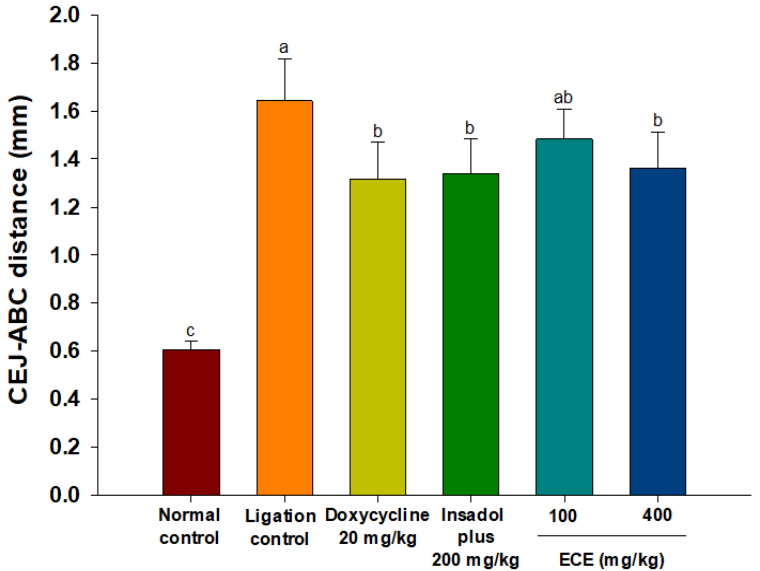
Figure 5. Effects of ECE on CEJ-ABC distance in ligature-induced periodontitis rats. Bars with different letters indicate significant differences (n = 6, p < 0.05). ECE: Ecklonia cava extract; CEJ-ABC: cement enamel junction-alveolar bone crest.